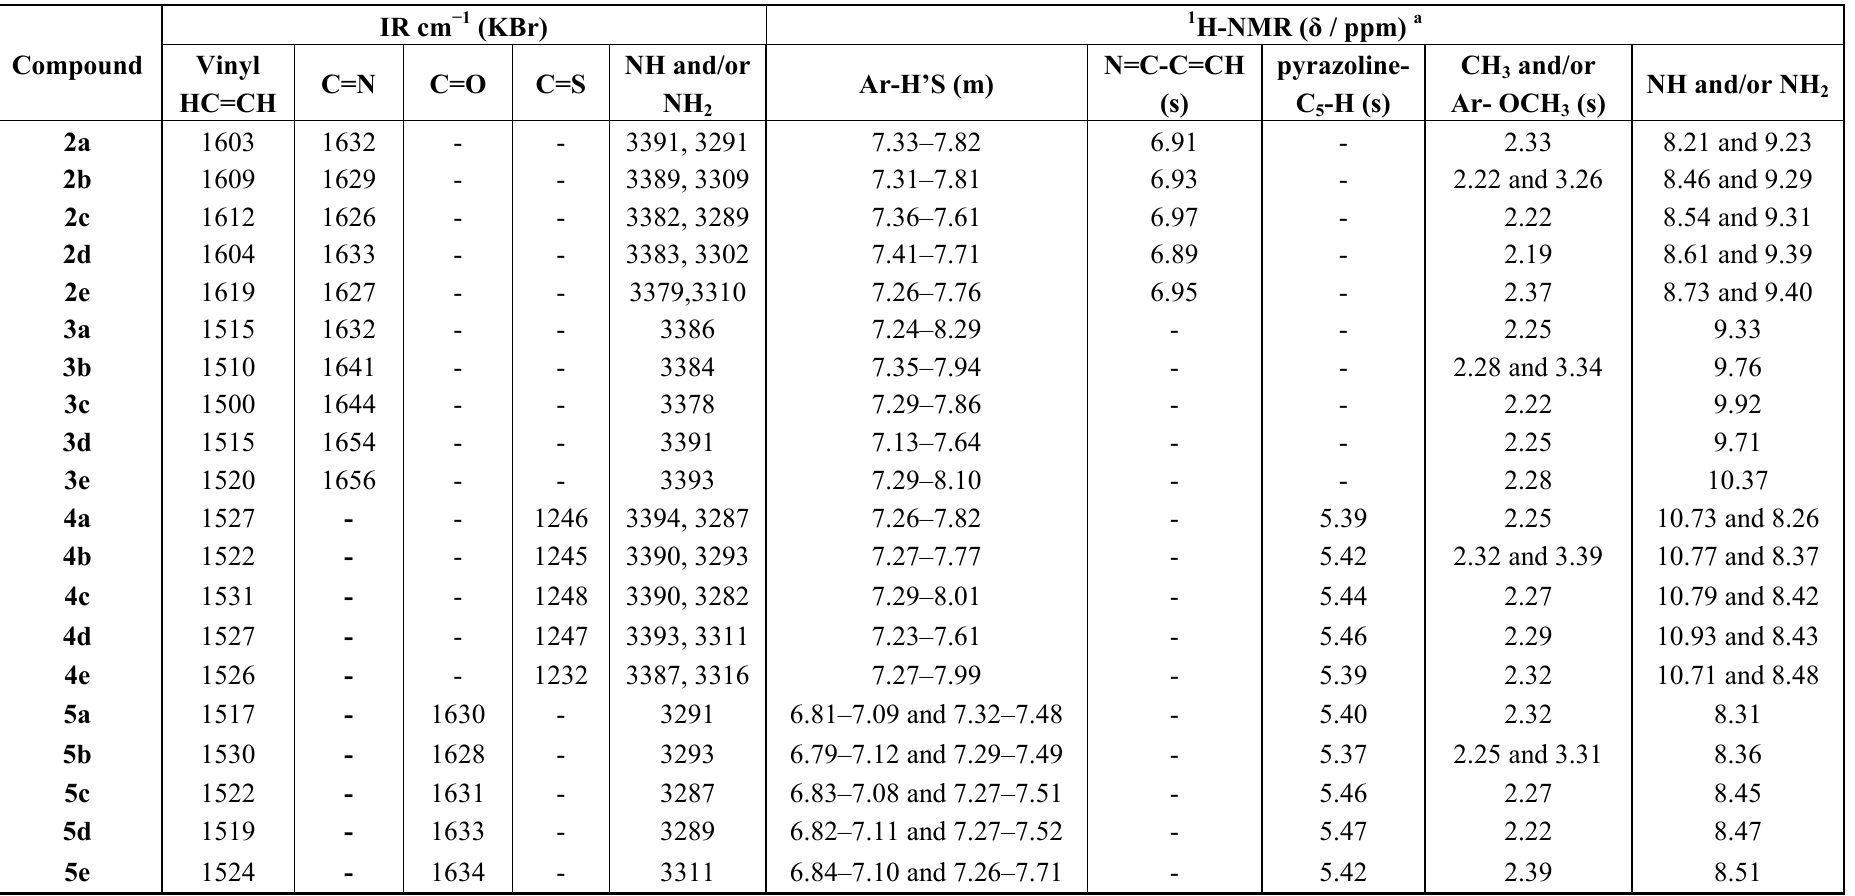
Table 2. IR and 1 H-NMR spectral data of compounds 2a – e , 3a – e , 4a – e , and 5a – e